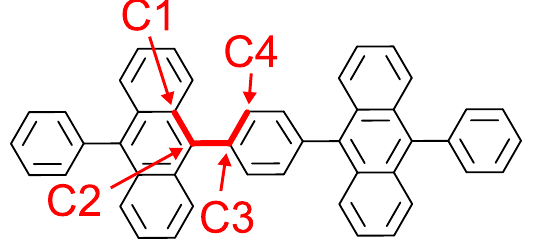
Figure 1. Bisanthracene derivative,